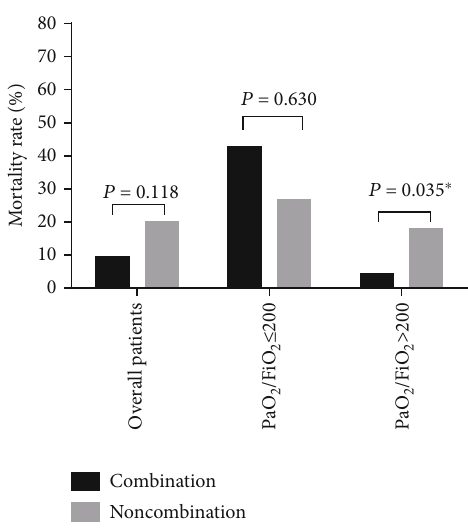
Figure 2: Mortality rates of patients with treatments of either combined echinocandins or noncombined echinocandins.